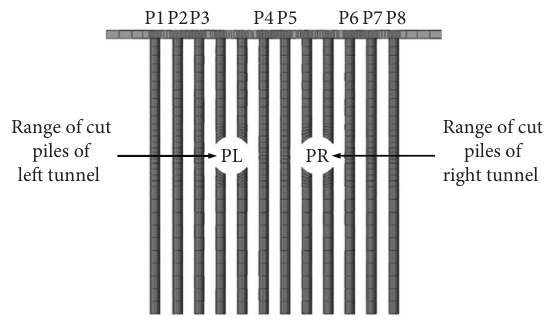
Figure 9: Numbers and locations of